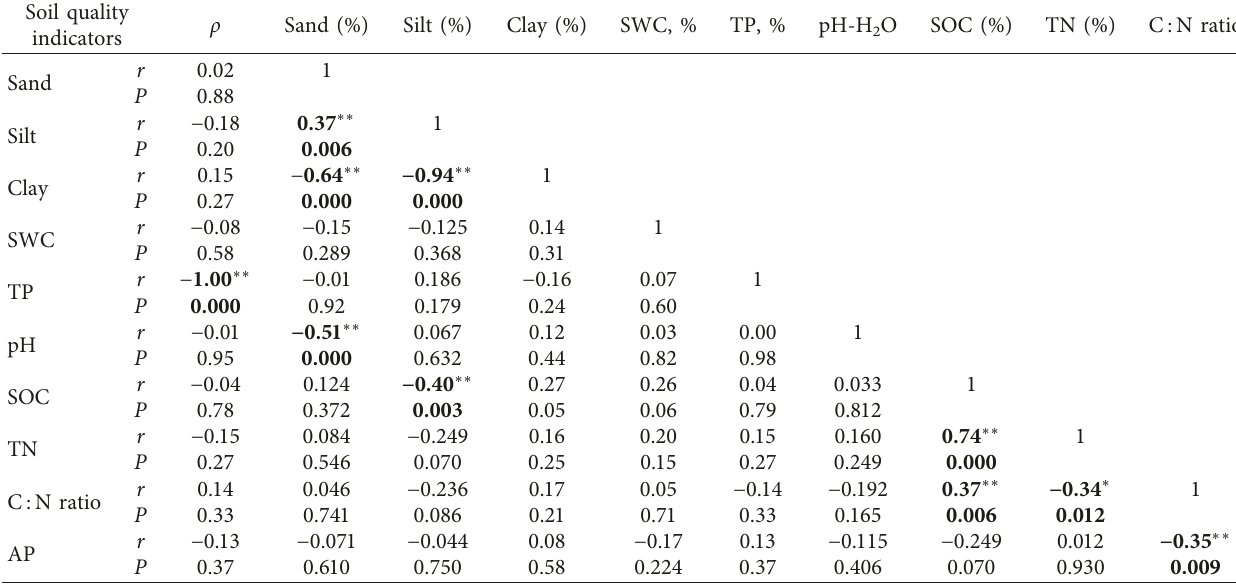
Table 7: Pearson’s correlation coefficient between soil quality indicators of SWC measures in Geshy subcatchment. Soil quality